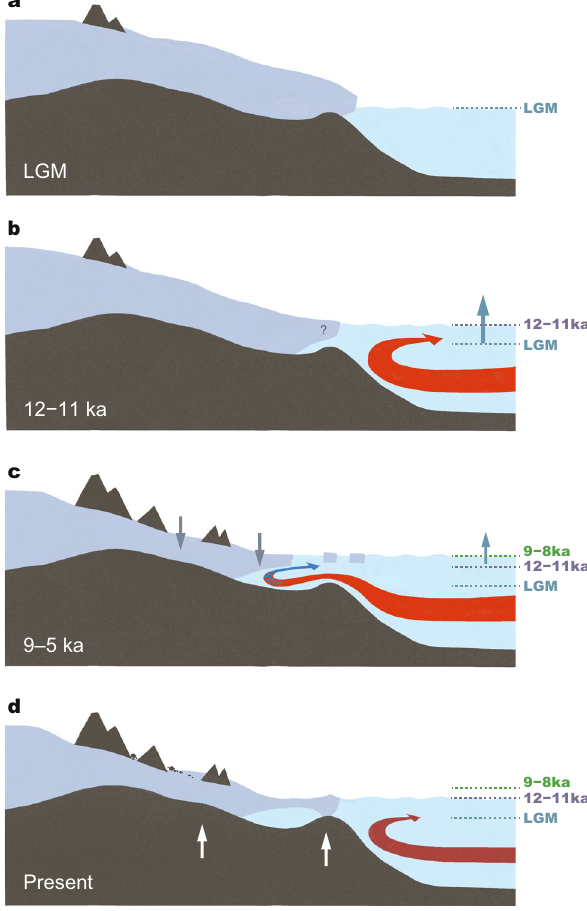
Fig. 8 Schematic image of a thinning of the EAIS across DML. a The EAIS advanced due to sea-level fall during the LGM 19 . b Warming of the CDW initiated retreat of the ice shelf, as observed in the Weddell Sea sector 20 . c Regional sea-level highstand triggered enhanced basal melting and calving of ice shelves, facilitated by the in fl ow of warmer CDW, which peaked at 9 – 8 ka and continued to ~5 ka, resulting in grounding line retreat and ice- sheet thinning. d Sea-level fall due to the GIA of the Antarctic continent stabilized ice shelves and/or may have caused a readvance of the EAIS, supported by pinning on ice rises and ice rumples along the DML margin 44